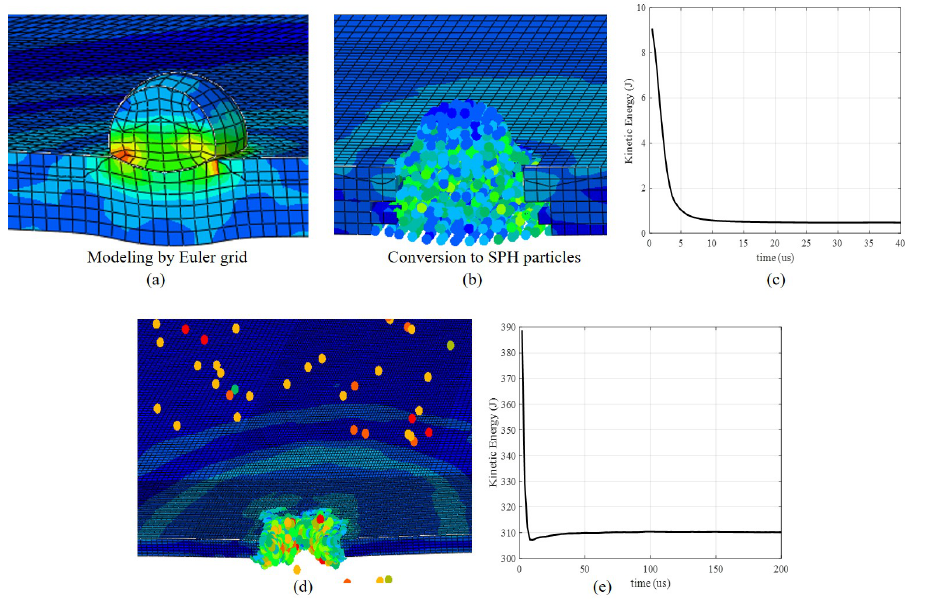
Figure 5. Local screenshot of simulation with a 3.8 mm projectile. ( a ) The Euler grid can still work well under low-velocity impact with a 500 m/s projectile; ( b ) conversion Euler grid to SPH particles when the strain rate is above 0.01; ( c ) the curve of Kinetic energy with time with the velocity of a projectile is 500 m/s; ( d ) the target plate is penetrated with the speed of a projectile is four km/s; ( e ) the curve of Kinetic energy with time with the velocity of a projectile is four km/s.